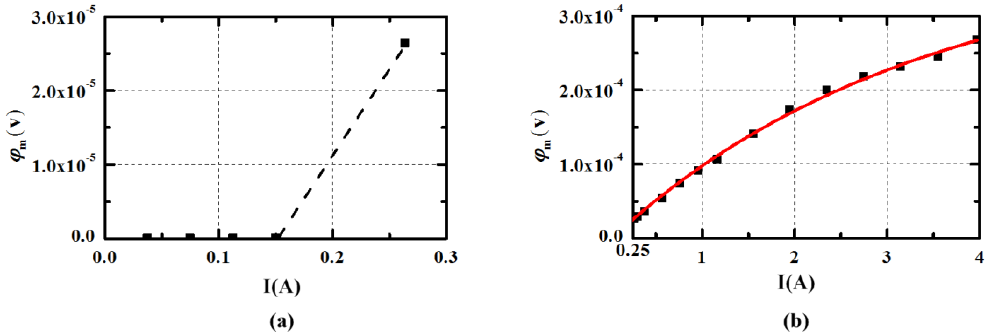
Figure 13. The voltage φ m between the measuring electrodes when applied different current I . (The dotted portion means that the stable display cannot be acquired).